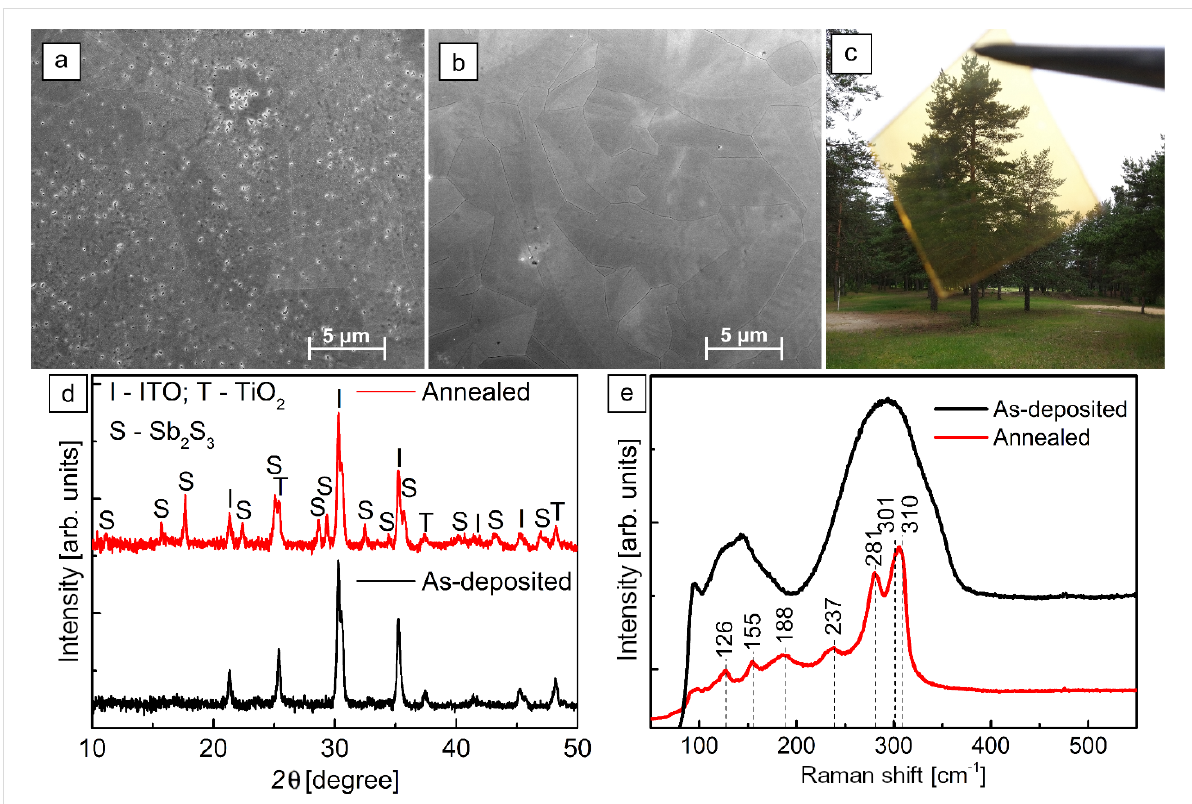
Figure 1: Surface views, by scanning electron microscopy (SEM) of 70 nm (a) and 100 nm (b) thick annealed Sb 2 S 3 layers on a glass/ITO/TiO 2 sub- strate. Photograph (c) of a 5 × 5 cm semitransparent (AVT 26%) stack of glass/ITO/TiO 2 /100 nm annealed Sb 2 S 3 , photographed by J. S. Eensalu. X-ray diffraction patterns (d) and Raman spectra (e) of as-deposited and vacuum-annealed Sb 2 S 3 layers on glass/ITO/TiO 2 substrate.